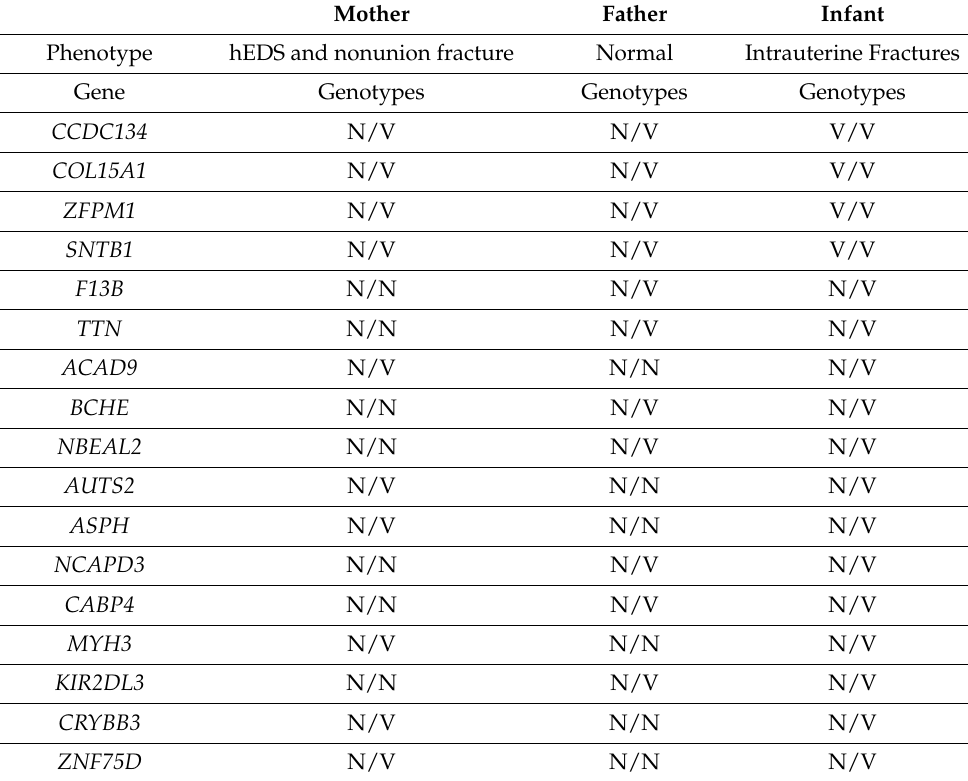
Table 1. Phenotype and genotypes of the